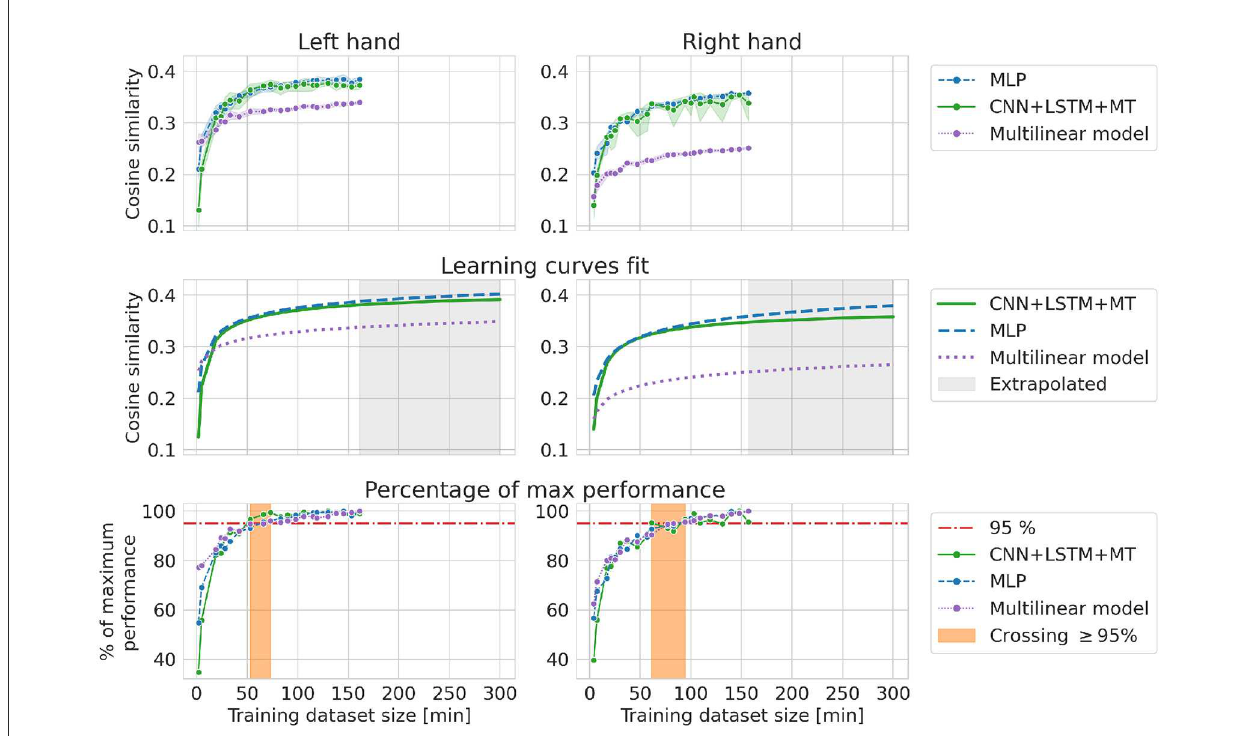
FIGURE10 Cosine similarity for random increase experiment, i.e., different training dataset sizes when randomly selecting a subset of observations from the first 22 sessions. Every evaluation was performed 10 times (left, right) .